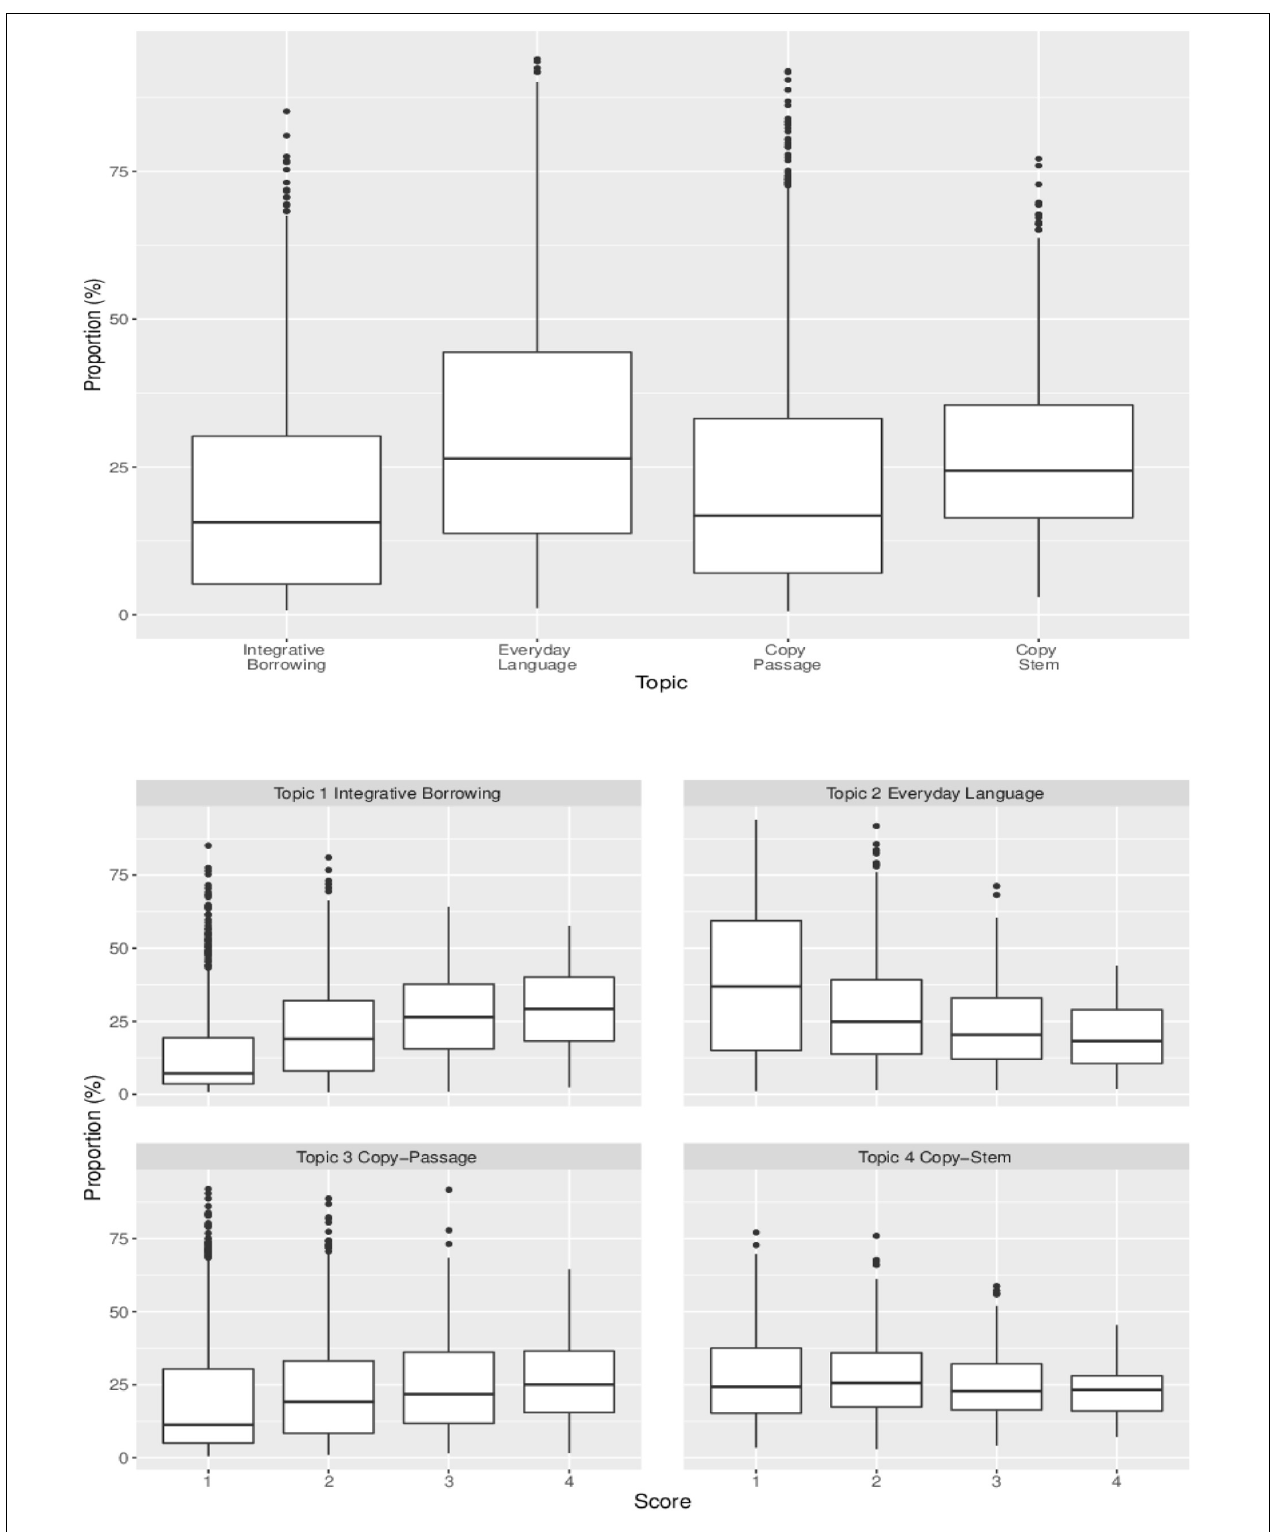
FIGURE 3 | Boxplot for topic proportion distribution. The plot on the upper panel presents the distributions of marginal topic proportions. The plots on the lower two panels present score distributions for each topic. For the plot on the lower panel, the X-axis indicates each score point and the Y-axis indicates the proportions of use of each topic. The whiskers on the boxes indicate variability outside the upper and lower quartiles and the horizontal lines in the boxes indicate the mean usage of the topic for the given score